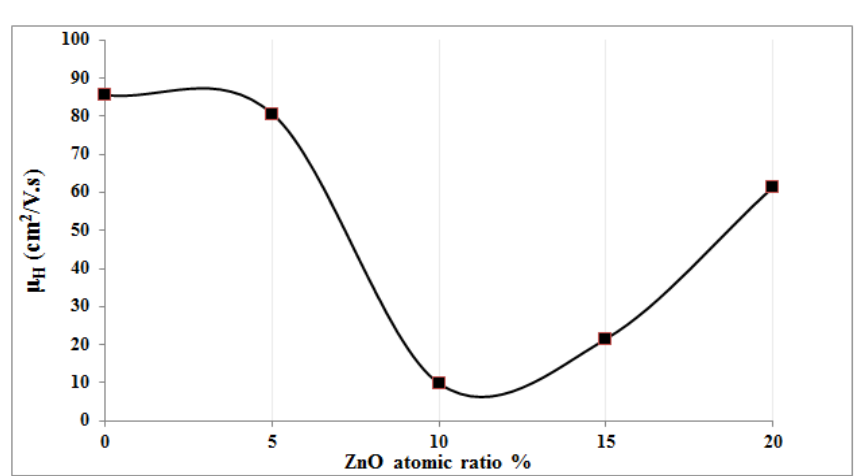
Fig. 5: Variation of mobility with ZnO atomic